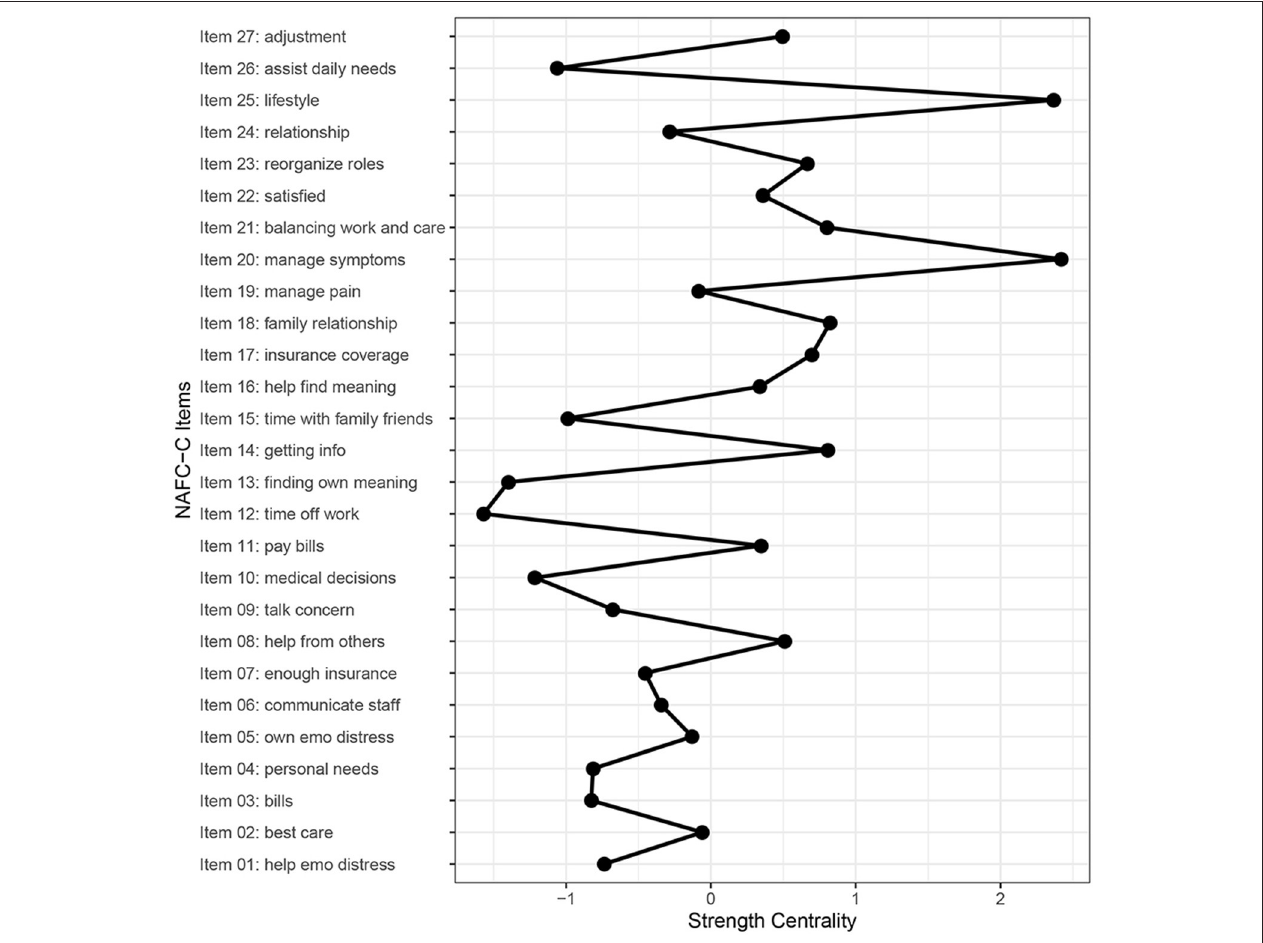
FIGURE 2 | Strength centrality for every item in the NAFC-C. Managing his/her other cancer-related symptoms (item 20) and dealing with lifestyle changes (item 25) had the highest strength while taking time off work (item 12) and finding meaning out of the experience with care recipient’s cancer (item 13) had the lowest strength.